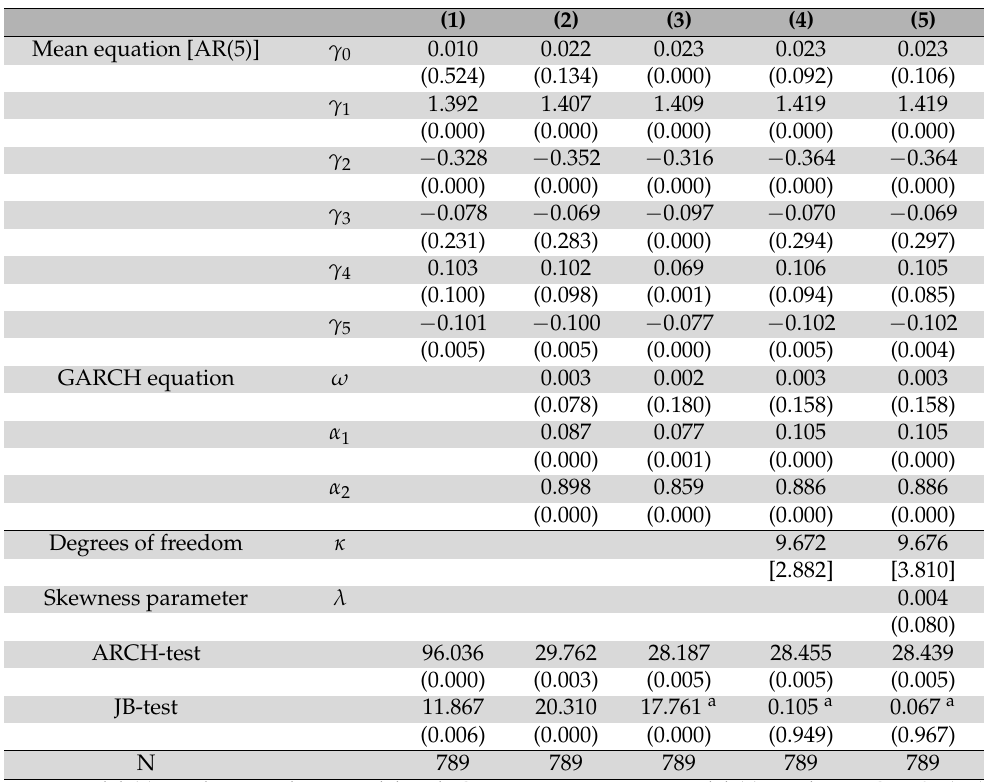
Table A4. Within–sample estimation results—real returns.